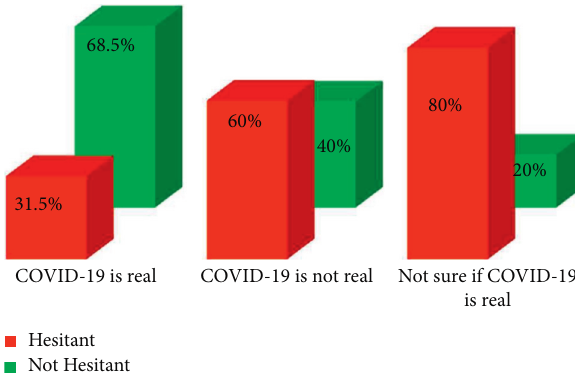
Figure 2: Perception of COVID-19 existence and vaccine hesitancy among HCWs in Imo State, Nigeria. Table 3: Contextual perception factors and vaccine hesitancy among HCWs in Imo State,